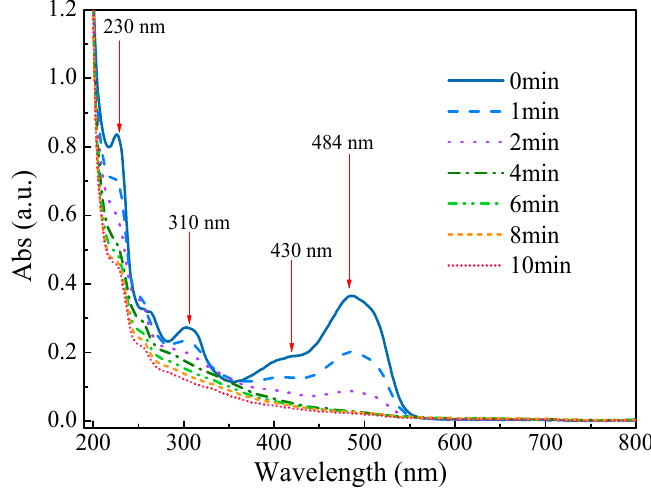
Figure 10. UV-vis spectra of Orange II decolorization at different times in the UVA-Fe 3+ -PMS-oxalate system ([Fe 3+ ] 0 = 100 µ M, [Orange II] 0 = 50 µ M, [PMS] 0 = 150 µ M, [oxalate] 0 = 80 µ M, under UVA irradiation, λ irr. = 365 nm, pH =